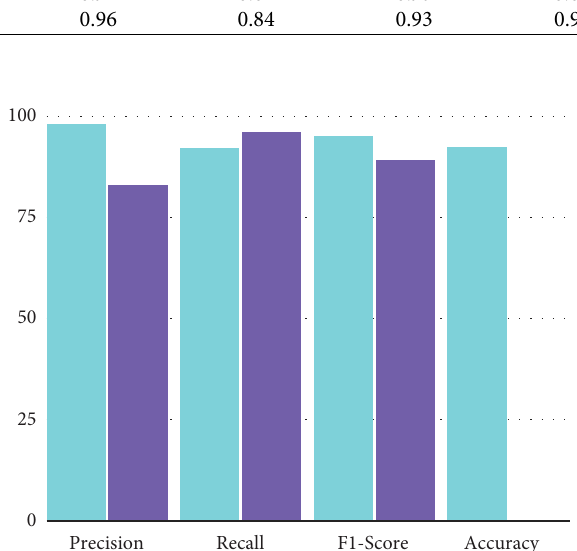
Figure 16: Gradient boosting machine graph.